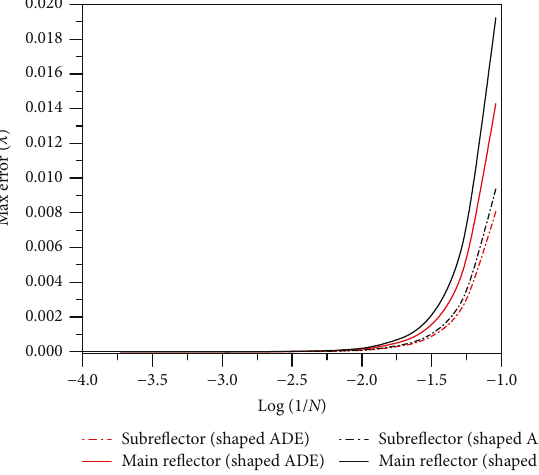
Figure 12: Maximum error of shaped ADE and ADC antennas as function of N .